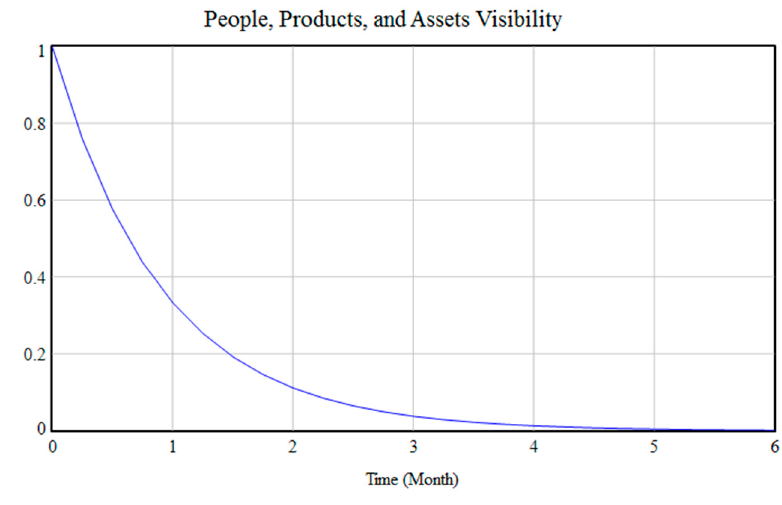
Figure 14. Simulation result of ‘people, products, and asset visibility’.